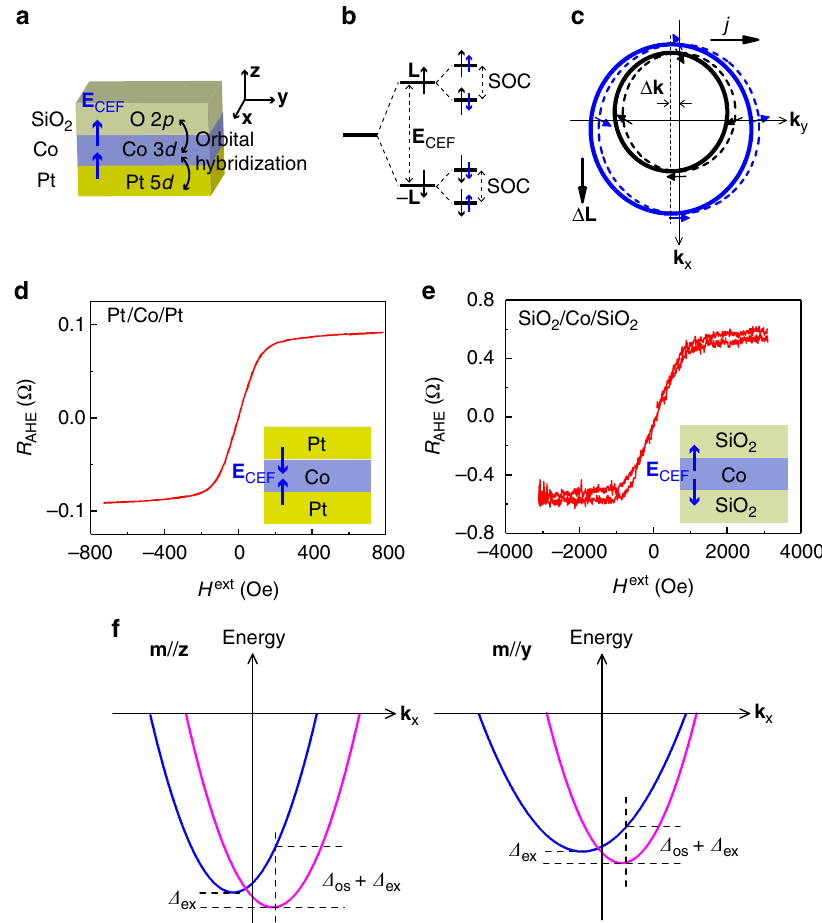
Fig. 6 Schema of the OREE. a Pt 5 d – Co 3 d and Co 3 d – O 2 p orbital hybridizations at the Pt/Co and Co/SiO 2 interfaces produce a E CEF at the respective interface. b Energy scales for illustration of how a degenerate state becomes split by E CEF and SOC. Here, the black and blue arrows represent the orbital and spin moments, respectively. c Sketch of simpli fi ed Rashba-like chiral orbital textures at the Fermi surface. The dashed black and blue circles represent the inner and outer Fermi contours with equilibrium, i.e., without current injection, respectively. The arrows indicate the orbital moments. A current density ( j ) injection along y shifts the outer and inner Fermi contours along − y (i.e., Δ k ), producing a lateral Δ L . d , e R AHE - H ext curves for the controlled samples Pt (5)/Co (1)/Pt (1)/SiO 2 (1)/Pt (1) (in nm, short for Pt/Co/Pt) and Pt (5)/SiO 2 (5)/Co (1)/SiO 2 (1)/Pt (1) (in nm, short for SiO 2 /Co/SiO 2 ). The insets show the interfacial E CEF con fi gurations of the two controlled samples. f Sketches of Rashba-type band structures for m || z and m || y to illustrate how the magnetization direction-dependent orbital torque